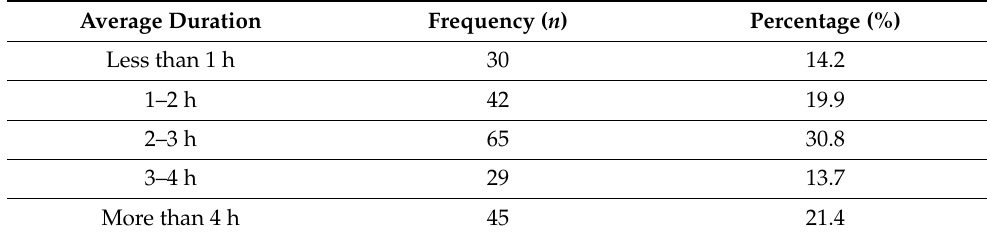
Table 3. Students’ average duration of daily electronic resources/applications for academic performance.